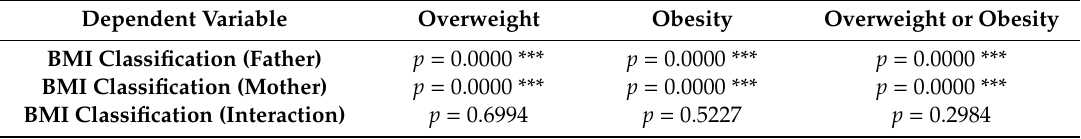
Table 7. Assessment of the statistical significance of individual e ff ects in logistic regression models.